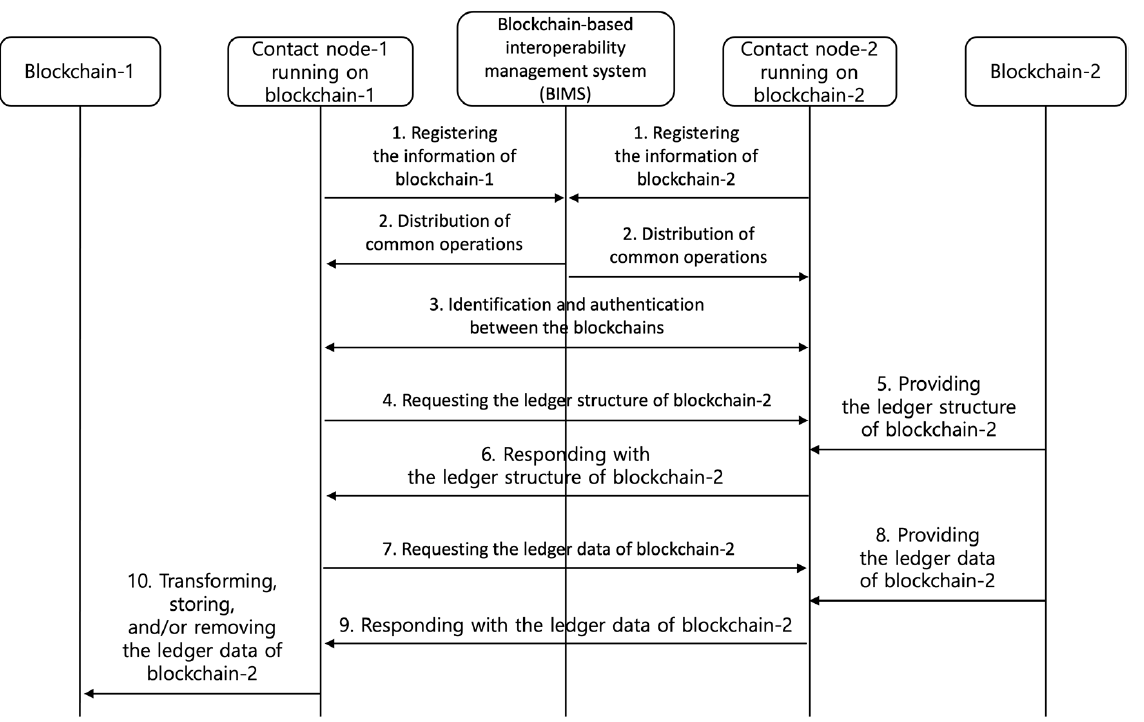
Figure 2. The ledger data sharing process based on the interoperable architecture between hetero- geneous blockchains.